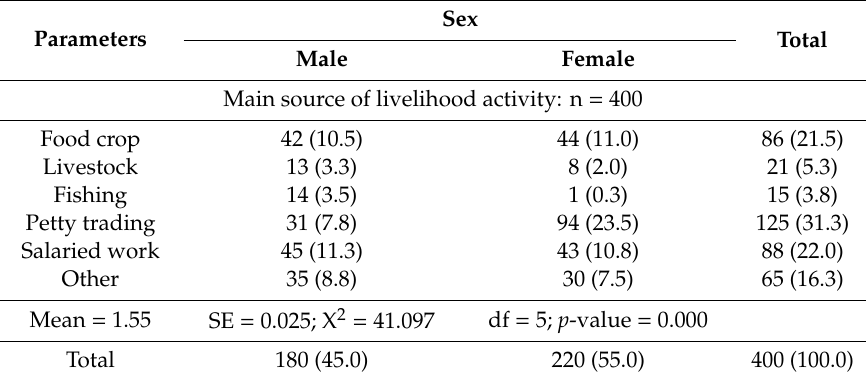
Table 6. Livelihood activities in the Owabi